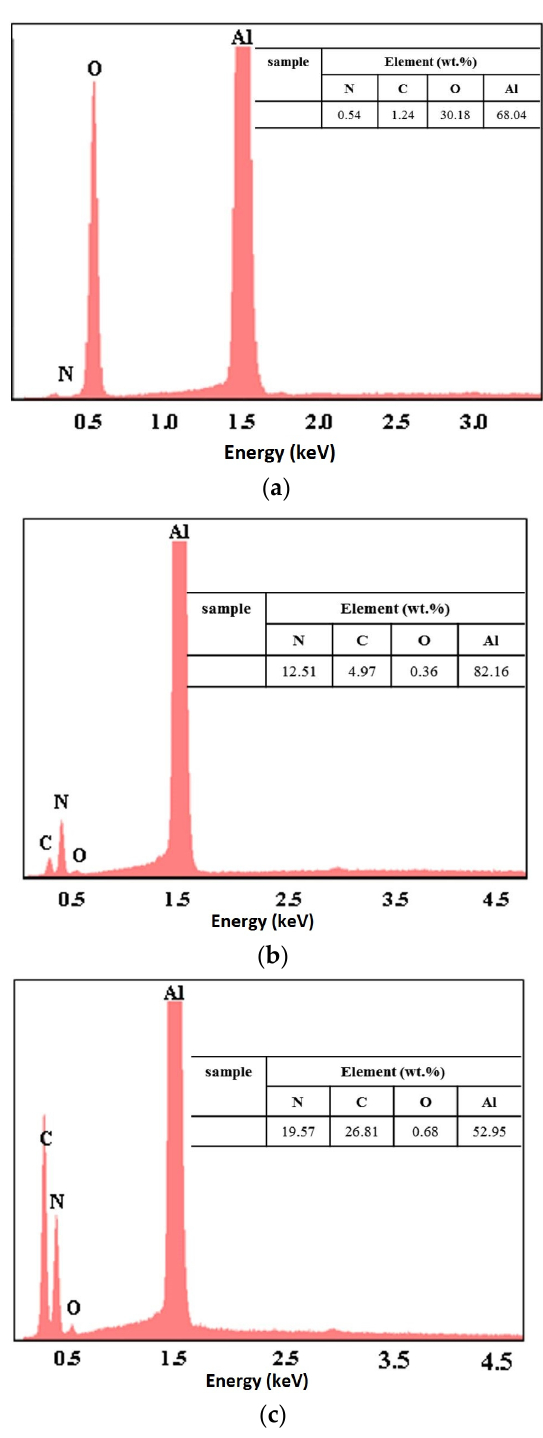
Figure 4. Energy X ‐ ray dispersive spectroscopy (EDS) results of the AlN ‐ coated carbon fibers Figure 4. Energy X-ray dispersive spectroscopy (EDS) results of the AlN-coated carbon fibers obtained obtained from AlCuF: ( a ) T15ANF; ( b ) T16ANF; ( c ) T17ANF. from AlCuF: ( a ) T15ANF; ( b ) T16ANF; ( c )